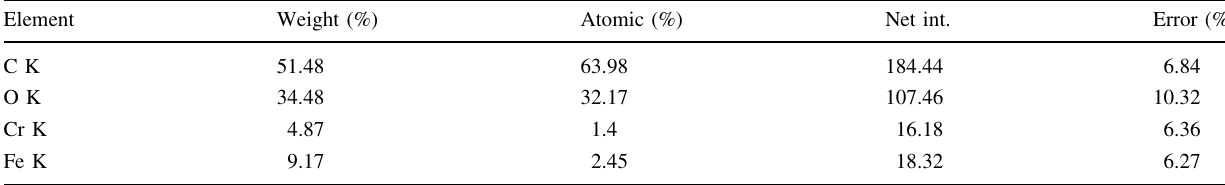
Table 3 Various elements present onto the tea waste biomass after simultaneous adsorption of Cr(VI) and phenol Element